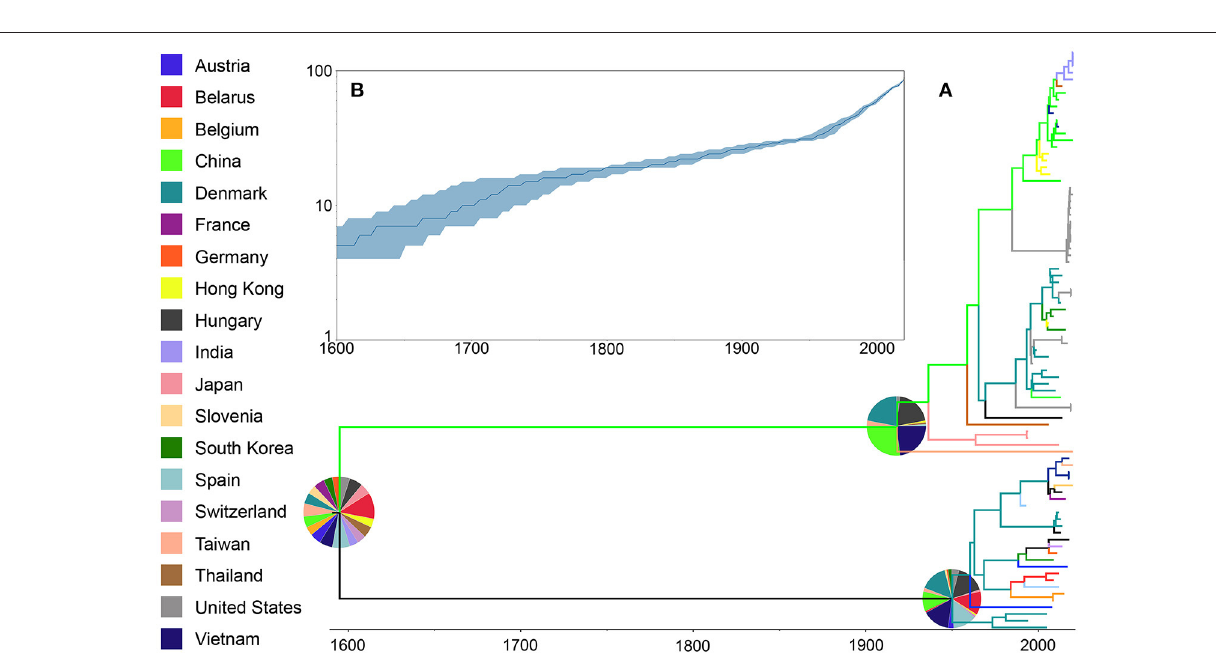
FIGURE 2 | Phylogenetic history of PRRSV inferred using whole genome sequences. (A) Maximum clade credibility (MCC) phylogeny, colored according to the country of origin of each sequence. The probabilities of ancestral states (inferred from the Bayesian discrete-trait analysis) are shown in pie charts on each node. (B) Spatiotemporal patterns represented through lineages through time